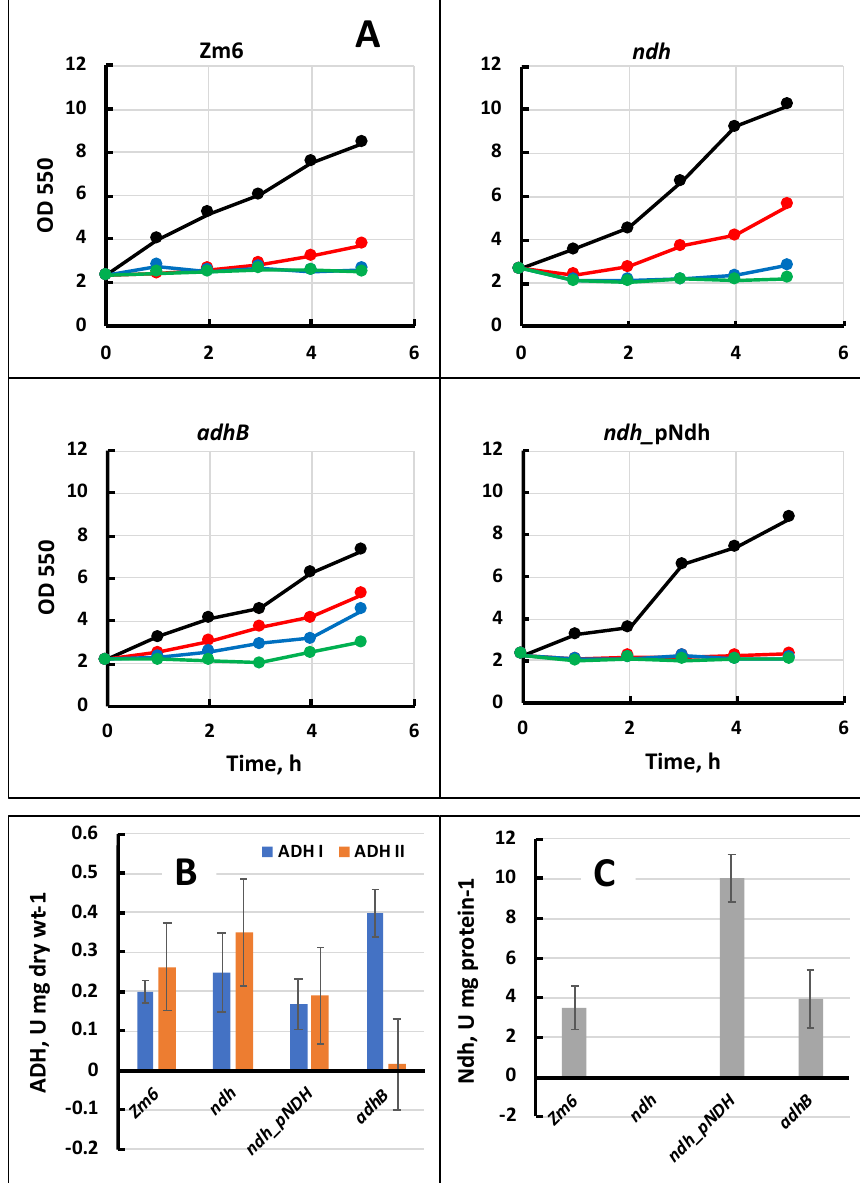
Figure 1. The effect of ADH II and Ndh activities on the growth of Z. mobilis strains in the presence of H 2 O 2 in the millimolar range. ( A ), growth of the wild type and mutant strains with H 2 O 2 at 0 mM (black), 2 mM (red), 4 mM (blue), and 6 mM (green) final concentration; ( B ), activity of ADH I and ADH II in permeabilized cells, and ( C ), activity of NADH:CoenzymeQ 1 oxidoreductase in cell membrane preparations. For details see the text.